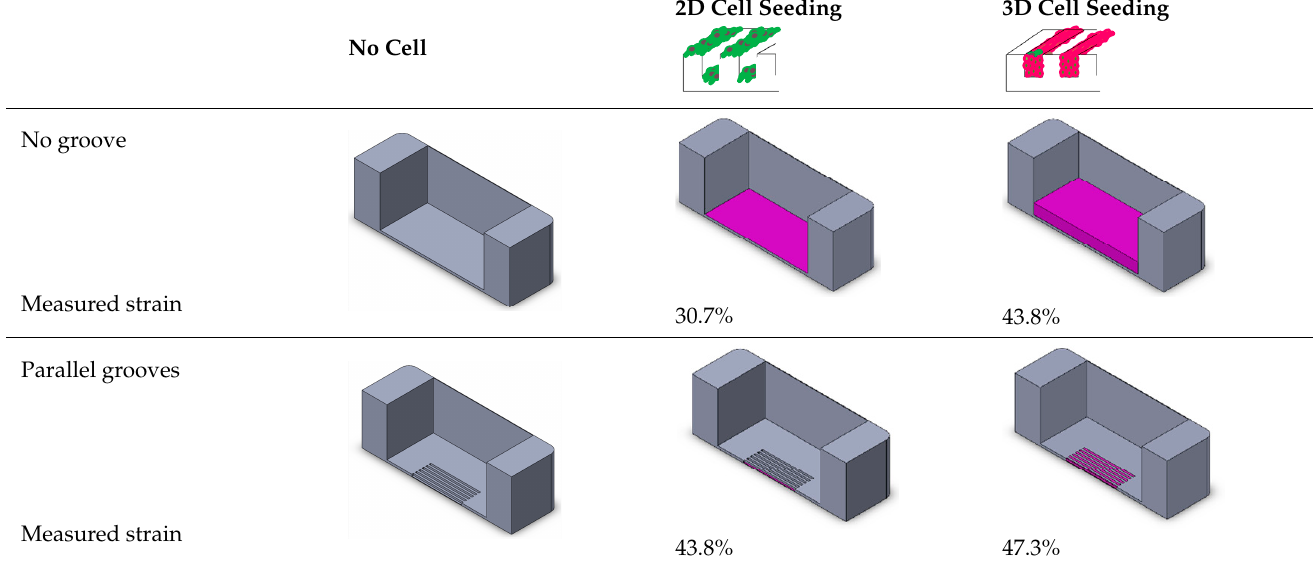
Table 1. Presentation of the 9 different geometrical and cell seeding cases that were analyzed: without grooves, with grooves parallel to stretching, with grooves perpendicular to stretching, with no cells, with 2D cell layer, and with cells 3D seeded in a dECM fibrin hydrogel (applied stretch in all cases is 36%). 2D Cell Seeding No Cell